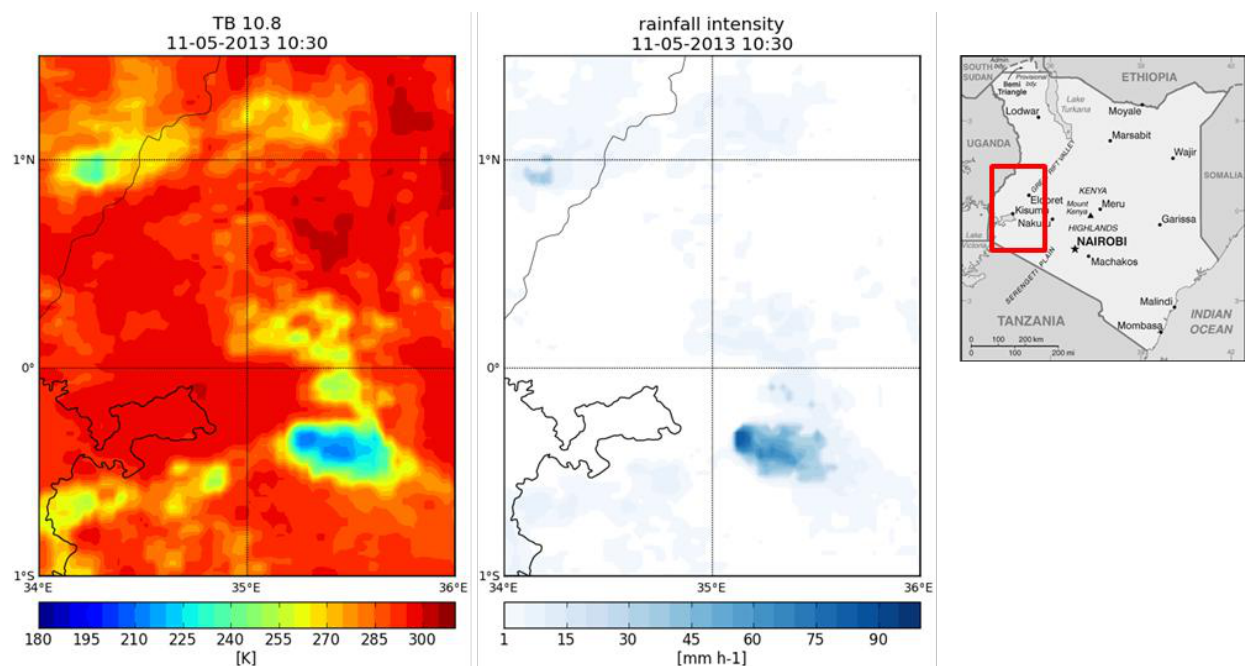
image B ( right B